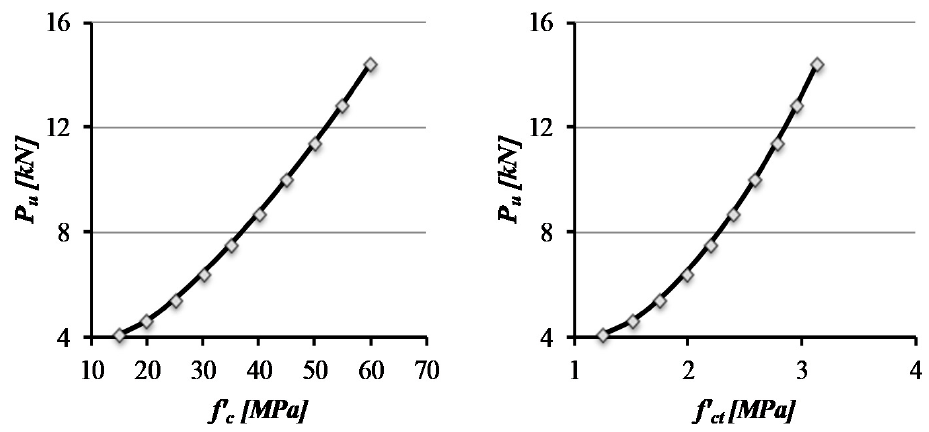
Figure 11. Influence of the concrete compressive ( left ) and tensile ( right ) strength on the debonding force.